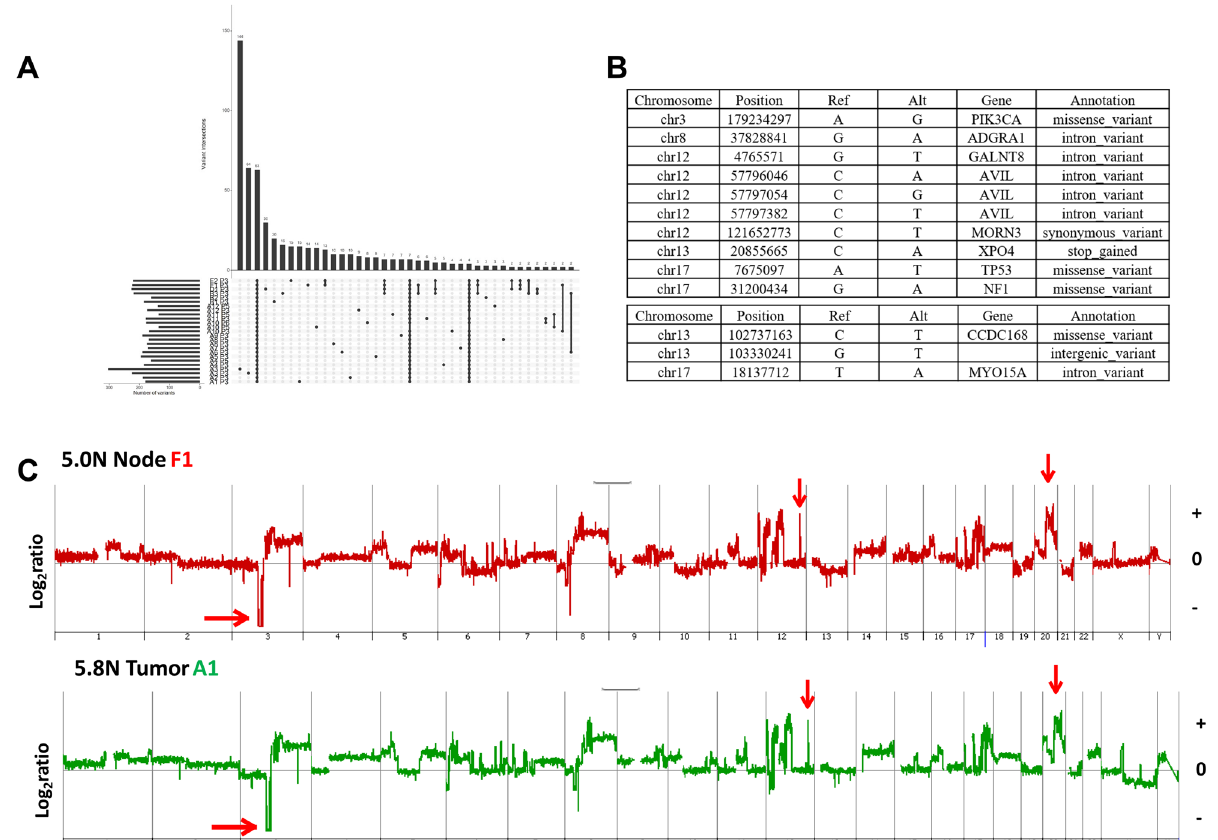
Figure 4. Shared and unique fixed variants in PS13-585. ( A ) Upset plot displaying patterns of variant sharing among samples. ( B ) Shared fixed somatic variants within the tumor (top) and node-specific shared fixed variants (bottom). ( C ) CNV plots of 5.8 N population from primary biopsy A1 and of 5.0 N population from distant node F1. Arrows denote shared focal CNVs homozygous deletion of 3p, and focal amplicons at 12q and